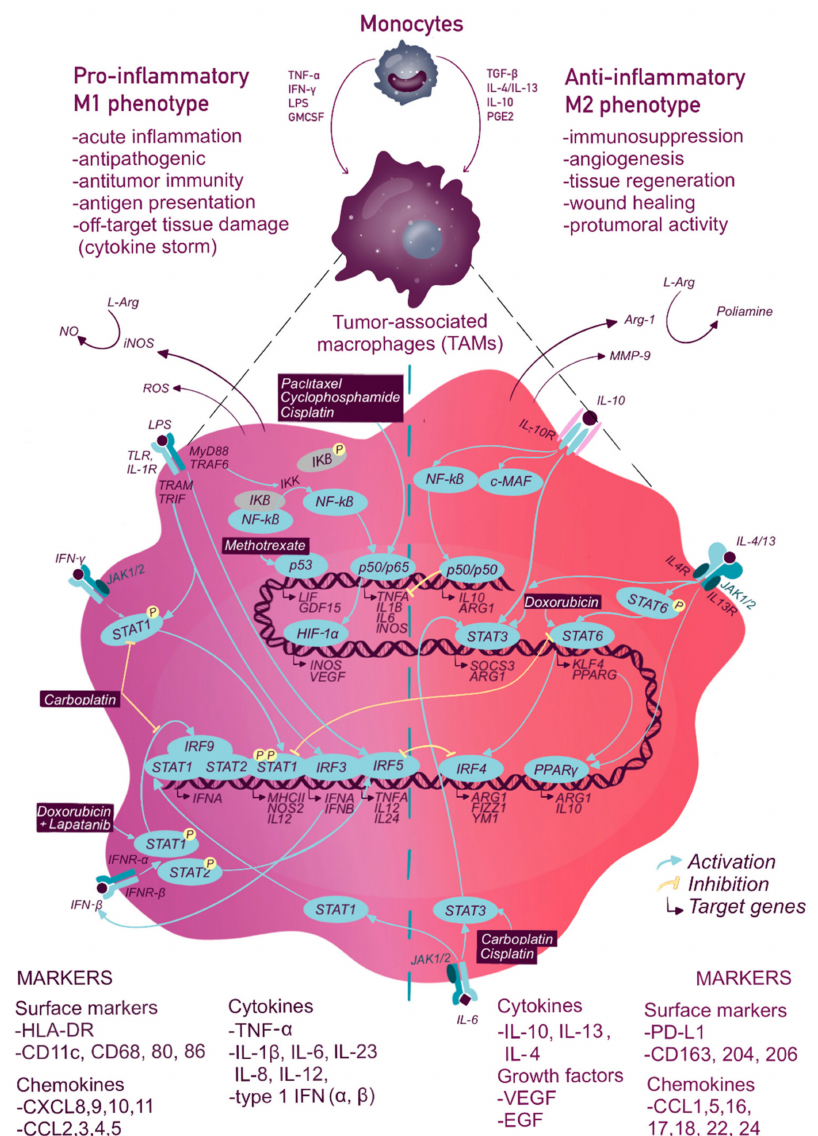
Figure 1. Transcription factors involved in macrophage polarization: impact of tumor microenvironment and chemother- apy. The activation or inhibition of signaling pathways are indicated by the blue arrows or by the yellow suppression symbols, respectively. The principal chemotherapeutic drugs, which impact macrophage transcriptional profiles, are shown. TAMs transcriptional patterns require phosphorylation (P) and activation of NF- κ B, STATs, IRFs, p53, and other TFs (Table 1) [11,12]. NF- κ B (P65-p50 heterodimer) becomes activated upon LPS stimulation and acts as a positive regulator